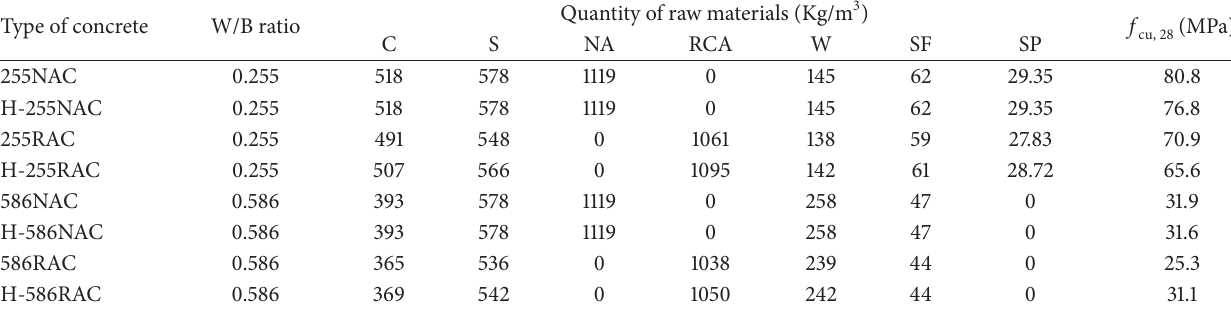
Figure 1: Process from NA to RCA and preparation of concrete. Table 1: Mix proportions and compressive strength of concretes # .